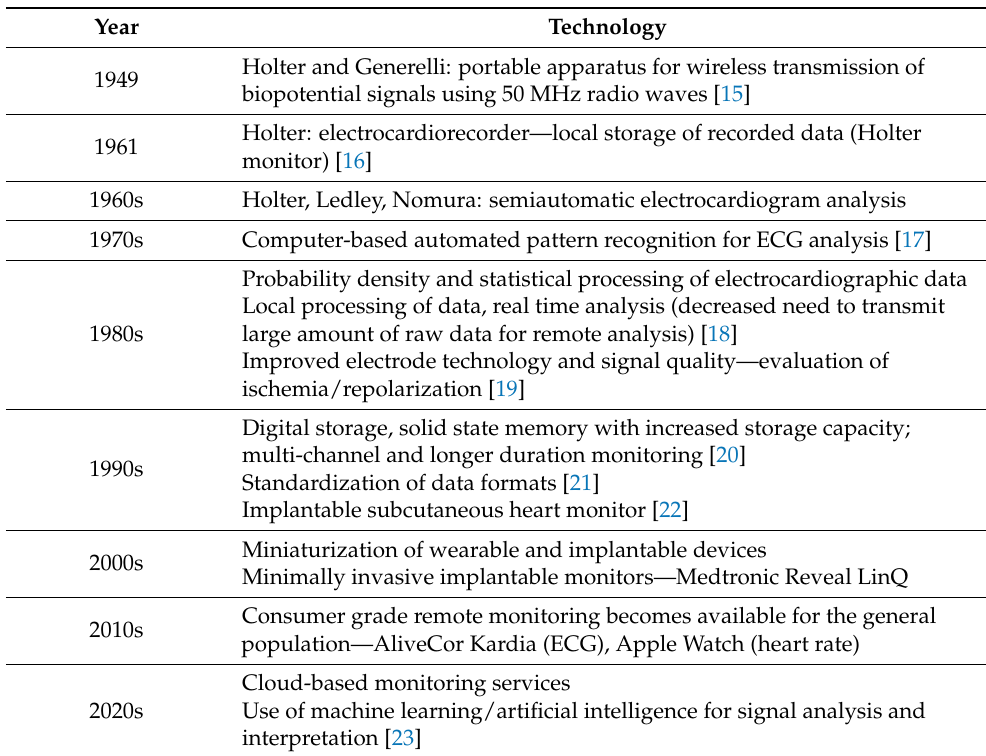
Table 3. Milestones in ambulatory and remote cardiac